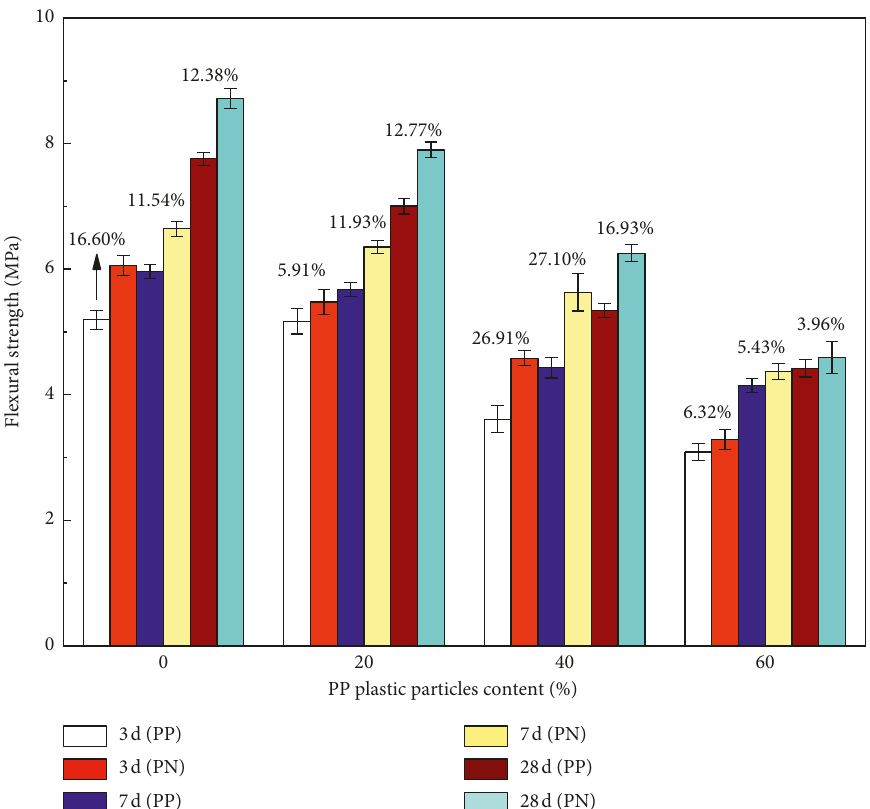
Figure 7: Evolution of the flexural strength of mortars as function of curing time (3, 7, and 28d). The error bars represent the standard deviation of three test specimens.